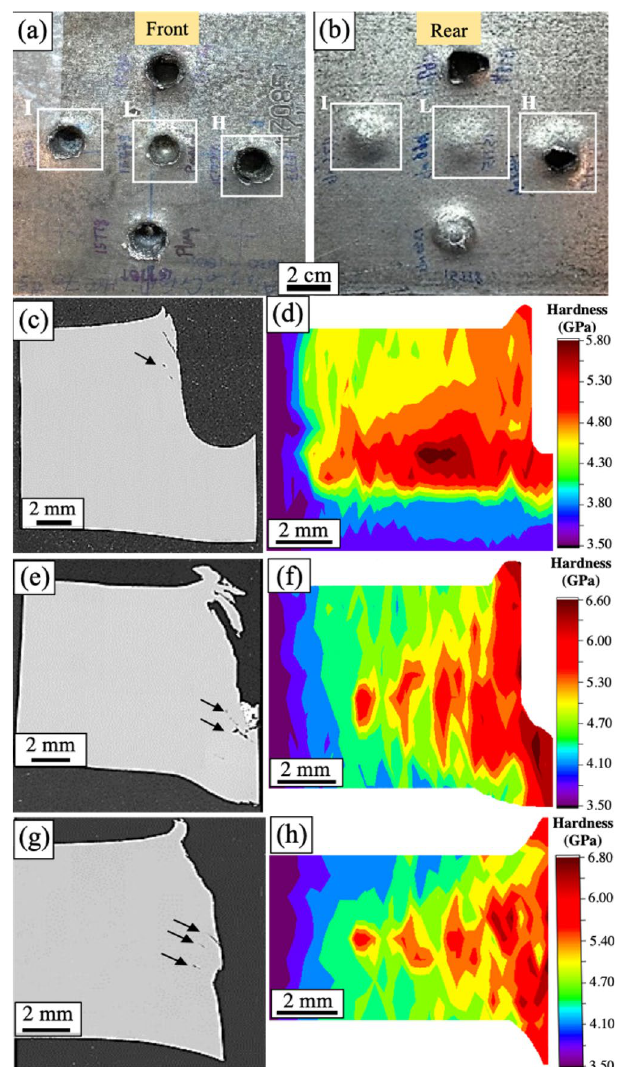
Figure 6. Ballistic impact and hardness contour maps: ( a ) front face and ( b ) rear face of the target plate showing the three shot conditions. Low velocity impact of 1066 m/s: ( c ) cross-sectional SEM image and ( d ) corresponding hardness contour map; Intermediate velocity impact of 1340 m/s: ( e ) cross-sectional SEM image and ( f ) corresponding hardness contour map; High velocity impact of 1465 m/s: ( g ) cross-sectional SEM image showing ductile hole growth failure with parallelly spaced macro-cracks indicated by black arrows and ( h ) corresponding hardness contour